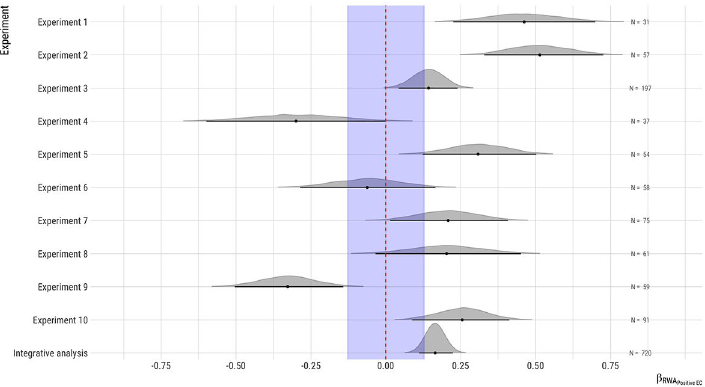
Note. The purple area corresponds to a region of practical equivalence where the values are considered equivalent to 0 (Kruschke, 2018). More information can be found in the Supplementary Materials. Figure 3.3 Forest Plot Showing Simple Slope Parameter Estimates for RWA in the Evaluation of Negatively Conditioned Greebles (Following Positive Counter-Conditioning)